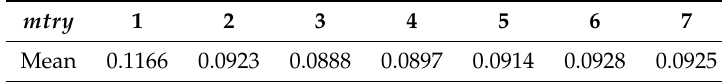
Table 9. Average Brier scores for the random forest